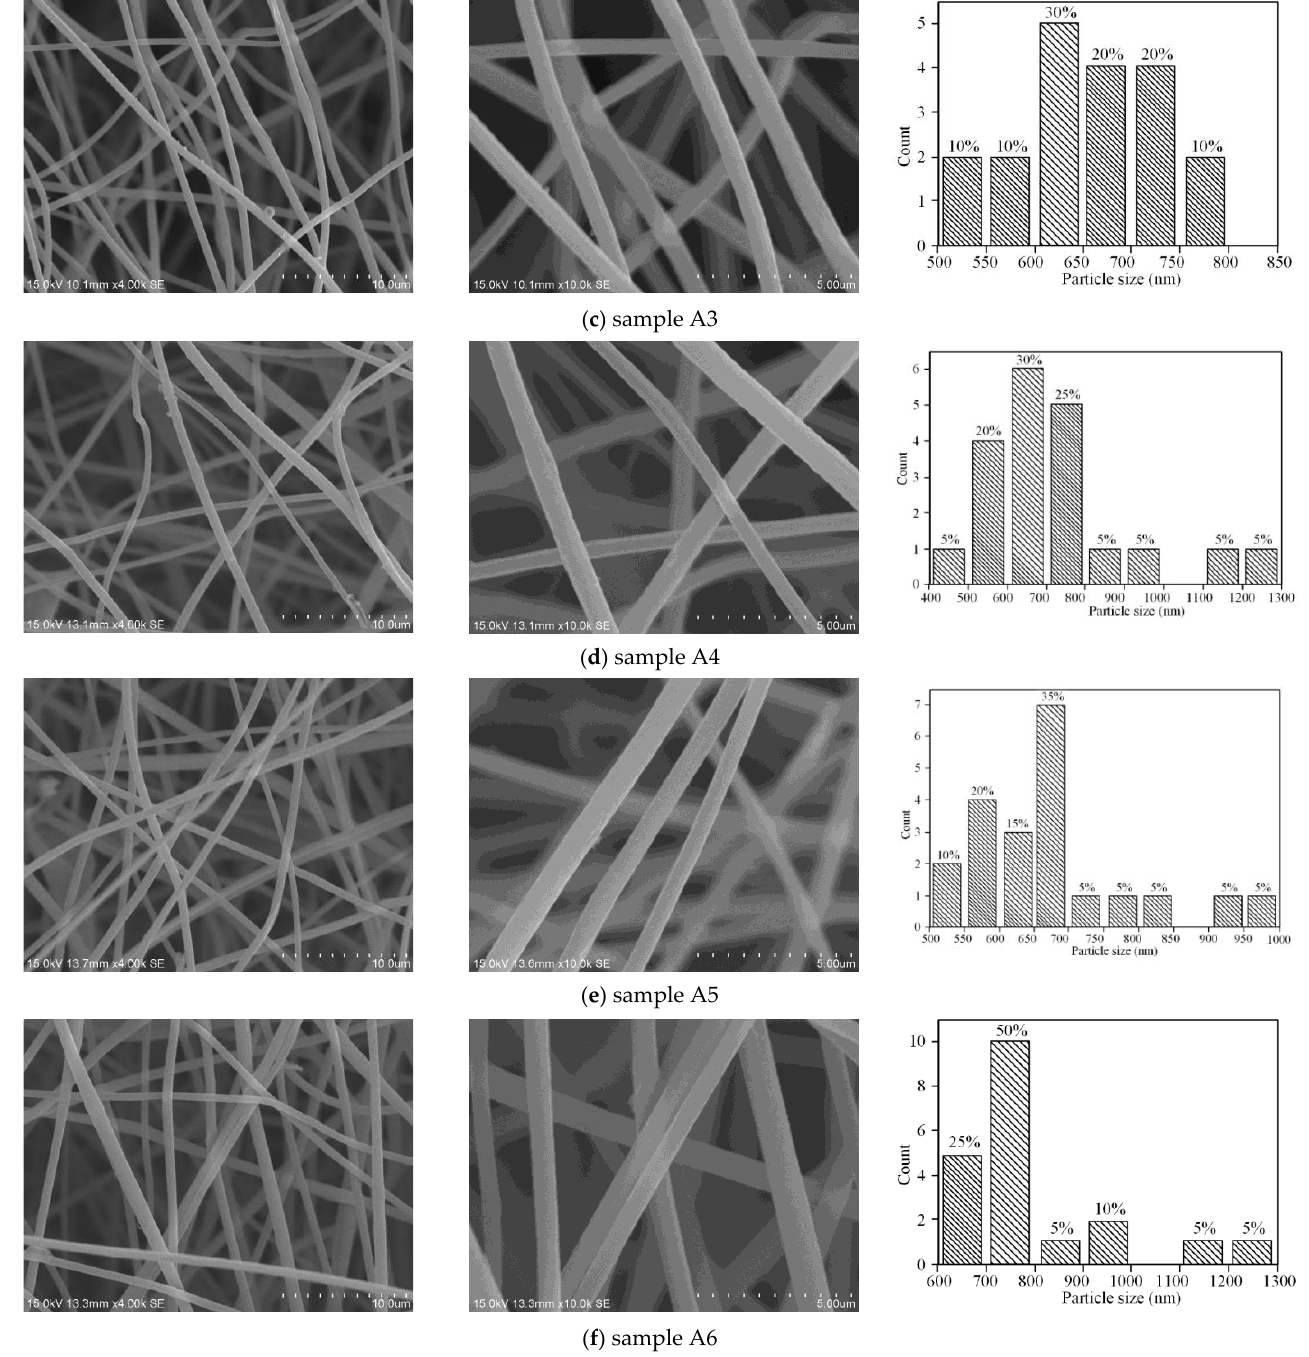
Figure 4. SEM picture of samples A1 –